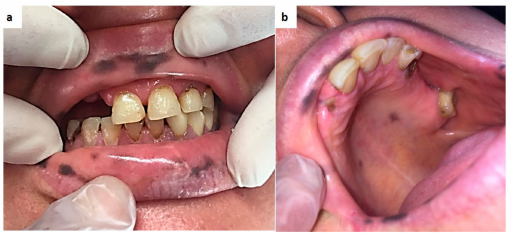
Figure 16. ( a , b ) Diffuse hyperpigmentations of the lips and oral mucosa in Peutz-Jeghers syndrome